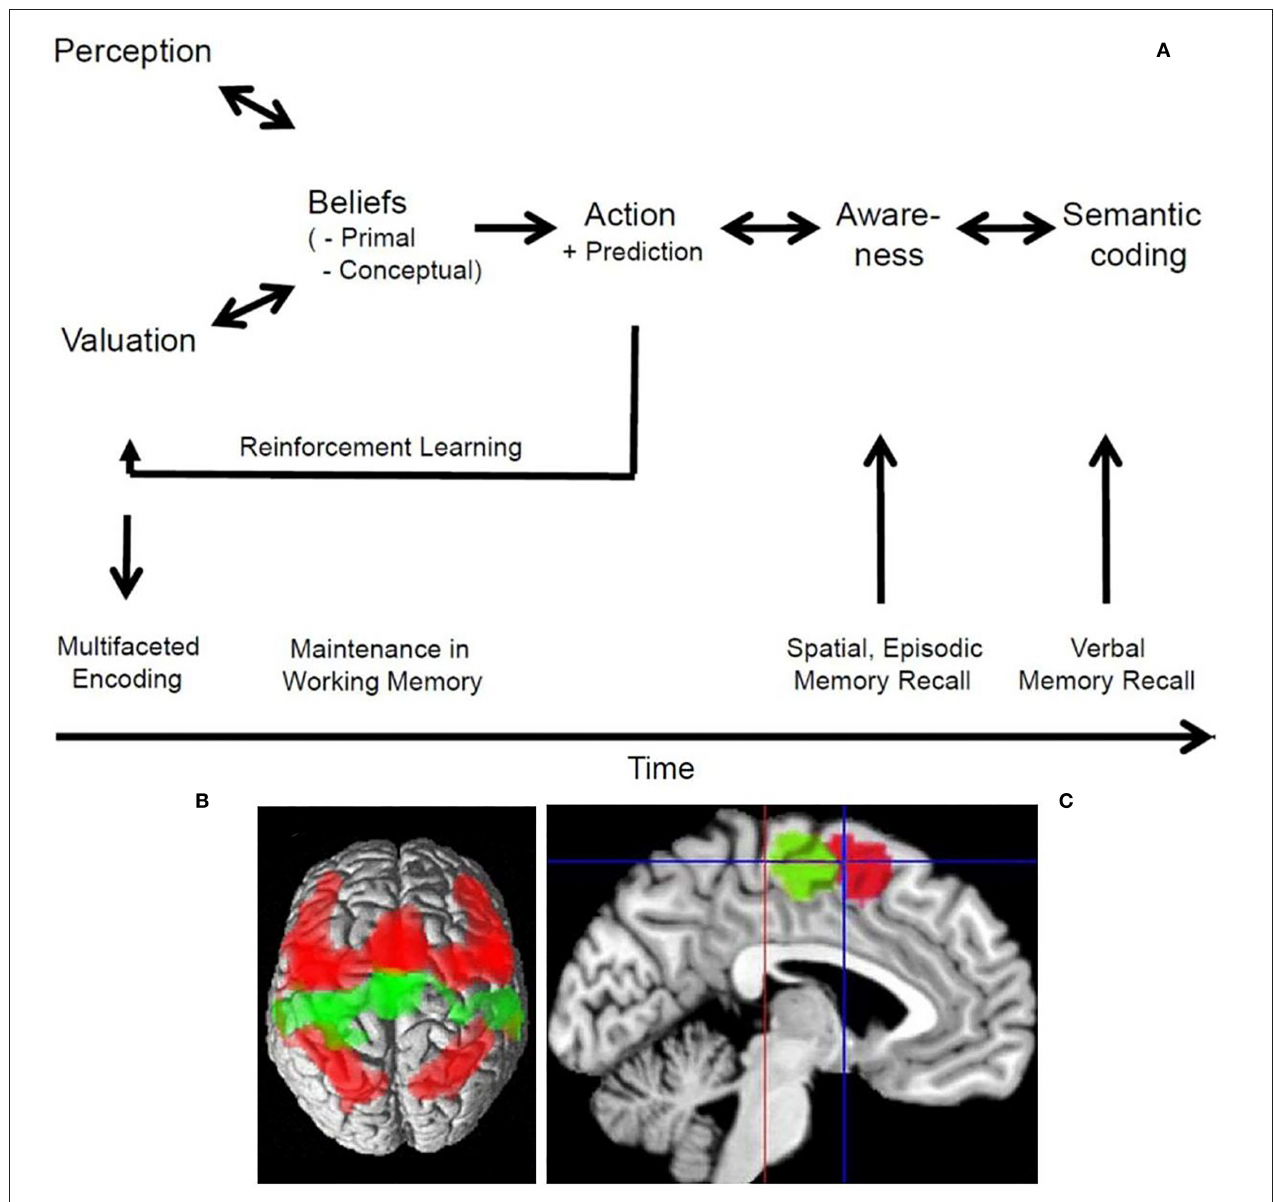
FIGURE 1 | The processes of believing and the dorsal medial frontal cortex. (A) Schematic drawing of the processes of believing and their close relation to memory functions. The bi-directional arrows account for putative bottom-up and top-down processing, while the uni-directional arrows indicate the major flow of information. Further details in Seitz et al. (2022). (B) The connectivity patterns of the SMA (green) and pre-SMA (red) as evident from a meta-analysis of functional imaging studies in a dorsal view on the brain. The SMA is predominantly connected bilaterally with the motor cortex, while the pre-SMA is predominantly connected bilaterally with the dorsolateral prefrontal as well as inferior and superior parietal cortex. Note, that the pre-SMA projects also to the SMA. (C) Medial aspect of the brain with cytoarchitectonic localization of the SMA (green) posterior and of the pre-SMA (red) anterior to the vertical plane through the anterior commissure (blue line); red line indicates the vertical plane through the posterior commissure. Further details in Ruan et al. (2018). To (B,C) the Creative Commons Attribution 4.0 International License (http://creativecommons.org/licenses/by/4.0/)